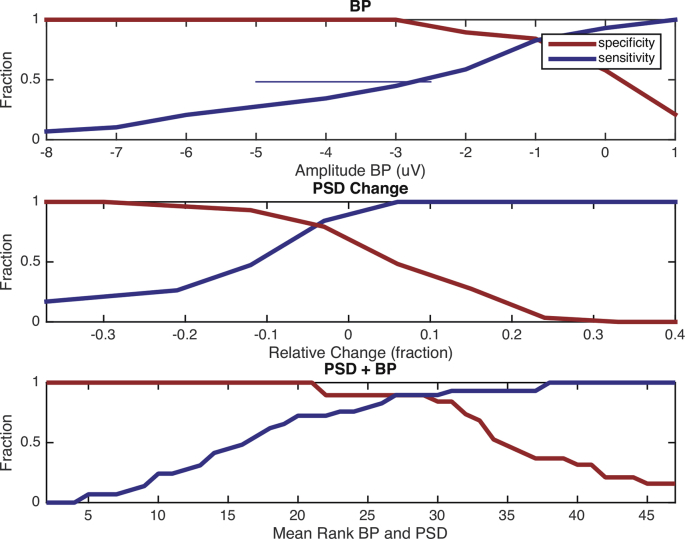
Correlation between the change in relative central (Cz) EEG 13–45 Hz power spectral density (13–45 Hz Change) prior to myoclonus jerks and the magnitude of the Bereitschaftspotential (BP) in cortical myoclonus (cortical, red dots) and functional jerks (functional, blue dots). The red line indicates the linear regression line for the cortical myoclonus group and the blue line the linear regression line for the functional myoclonus.